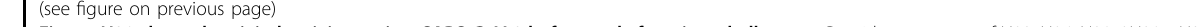
Fig. 1 4H30 showed antiviral activity against SARS-CoV-2 before and after virus challenge. a Peptide sequences of H23, H26, H30, 2H30, 4H30, and reference HBD2. Peptide 2H30 and 4H30 were 2-branched and 4-branched H30 cross-linked by lysine at the C terminal of H30. b The antiviral activity of these peptides in the high salt concentration (150 mM, PBS) was determined by plaque reduction assay ( n = 3). c The antiviral activity of these peptides against SARS-CoV-2 in the low salt concentration (30 mM, PBS/5) was determined by plaque reduction assay ( n = 3). P values were generated by comparison with an untreated virus (0). d The antiviral activity of 2-branched H30 (2H30) and 4-branched H30 (4H30) against SARS-CoV- 2 (HKU001a) in PBS was determined by plaque reduction assay ( n = 4). e The cytotoxicity of 4H30 in VeroE6 and Calu-3 cells was measured by MTT assay ( n = 3). f The antiviral activity of 4H30 was determined by anti-nucleocapsid (NP) immuno fl uorescent staining. SARS-CoV-2 with or without 4H30 treatment was added to cells for infection. Representative images were taken at 18 h post-infection (hpi) in VeroE6 cells. Scale bar, 20 μ m. g The post-infection antiviral activity of 4H30 against SARS-CoV-2 (B.1.1.63, D614G) in VeroE6 and Calu-3 cells ( n = 6). At 6 hpi, 4H30 (50 μ g/mL) was added to infected cells and viral titers in cell supernatants were measured at 24 hpi (for VeroE6 cells) or 30 hpi (for Calu-3 cells). h The broad-spectrum antiviral activities of 4H30 against SARS-CoV-2 variants and MERS-CoV (MERS) in VeroE6 cells were determined by plaque reduction assay ( n = 4). * P < 0.05 and ** P < 0.01 when compared with DMEM. P values were calculated by the two-tailed Student ’ s t -test. Data were presented as means ± SD of indicated biological samples with more than two independent